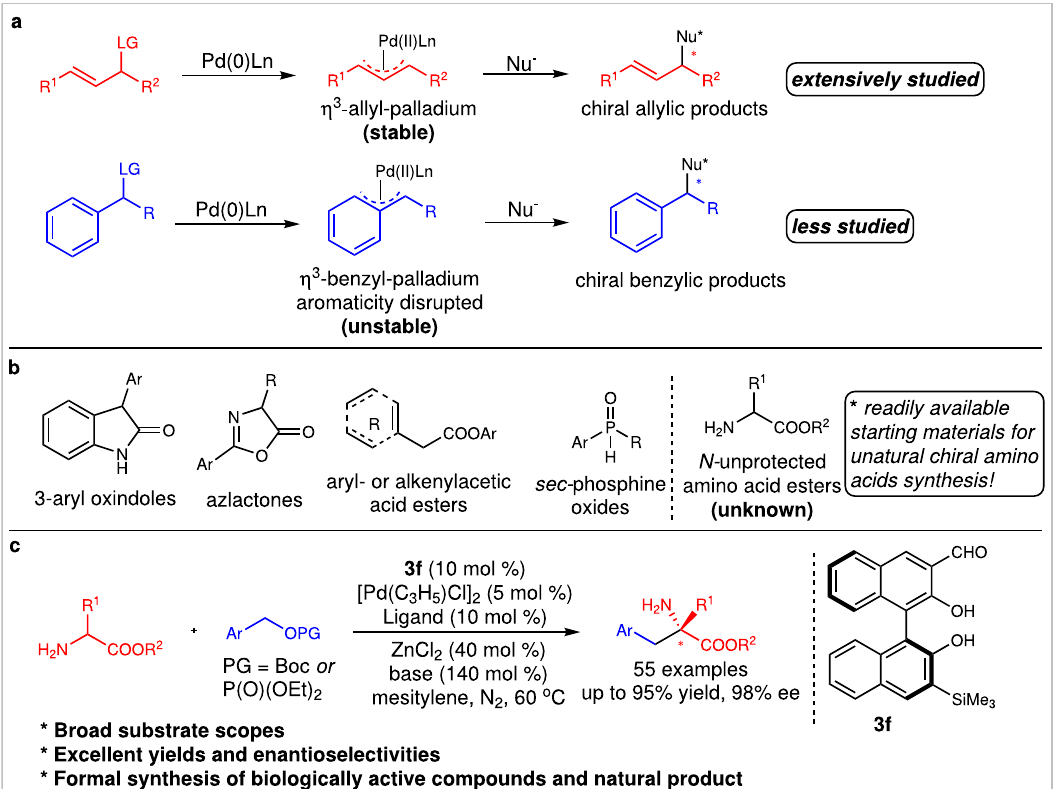
Fig. 1 The catalytic asymmetric Tsuji – Trost-type reactions. a The comparison of the allylation and benzylation reactions. b The reported prochiral nucleophiles involved in the catalytic asymmetric benzylation reactions. c The direct catalytic asymmetric α − benzylation of N-unprotected amino acid esters by a chiral aldehyde-involved catalytic system (this